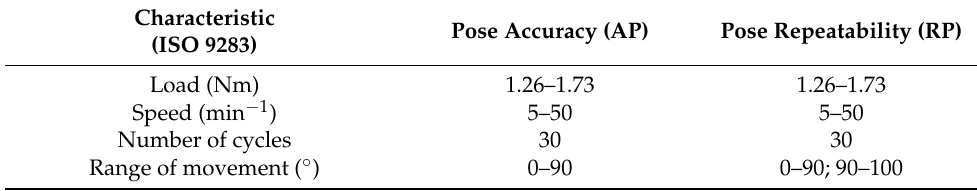
Table 2. Selected measuring tests and